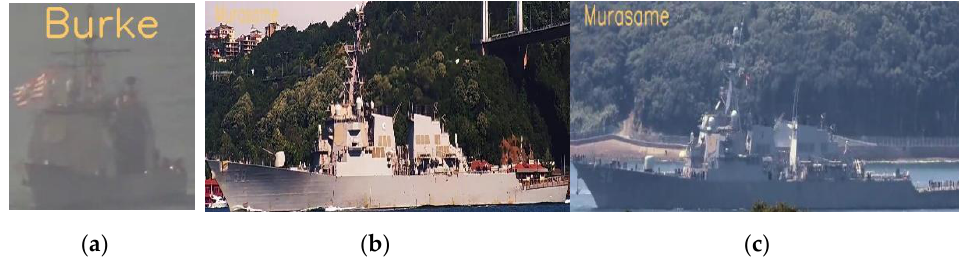
Figure 10. Misclassification examples: ( a ) misclassifying Ticonderoga as Arleigh Burke; ( b ) misclassifying Arleigh Burke as Murasame; ( c ) misclassifying Arleigh Burke as Murasame.